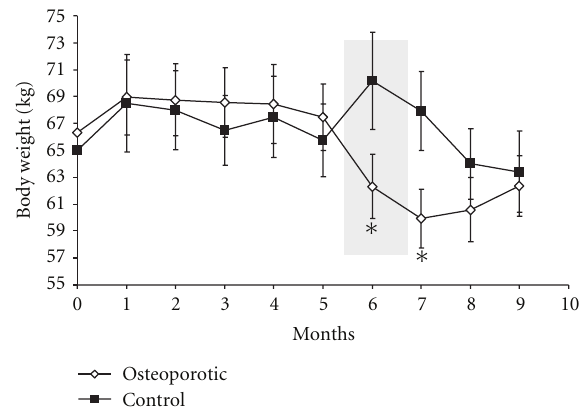
Figure 2: Body weight of control and osteoporotic sheep through- out the study. The highlighted gray area shows the period of corticosteroid withdrawal. Body weight was reduced during and one month after withdrawal of corticosteroids ( ∗ P < 0 . 05).